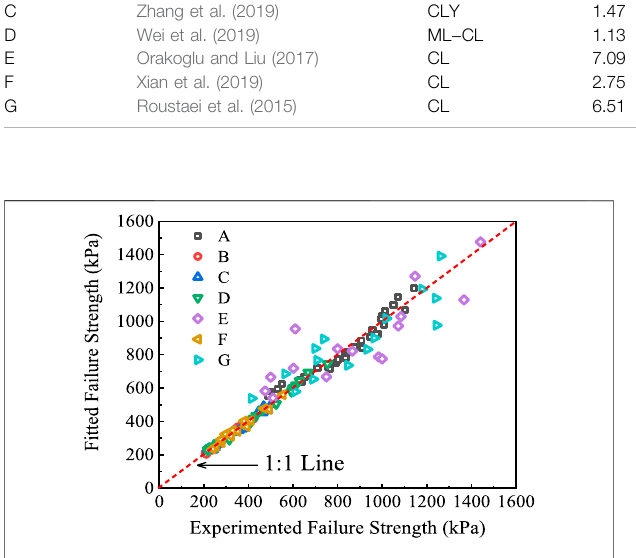
FIGURE 6 | Comparison between the fi tted and experimented failure strength.